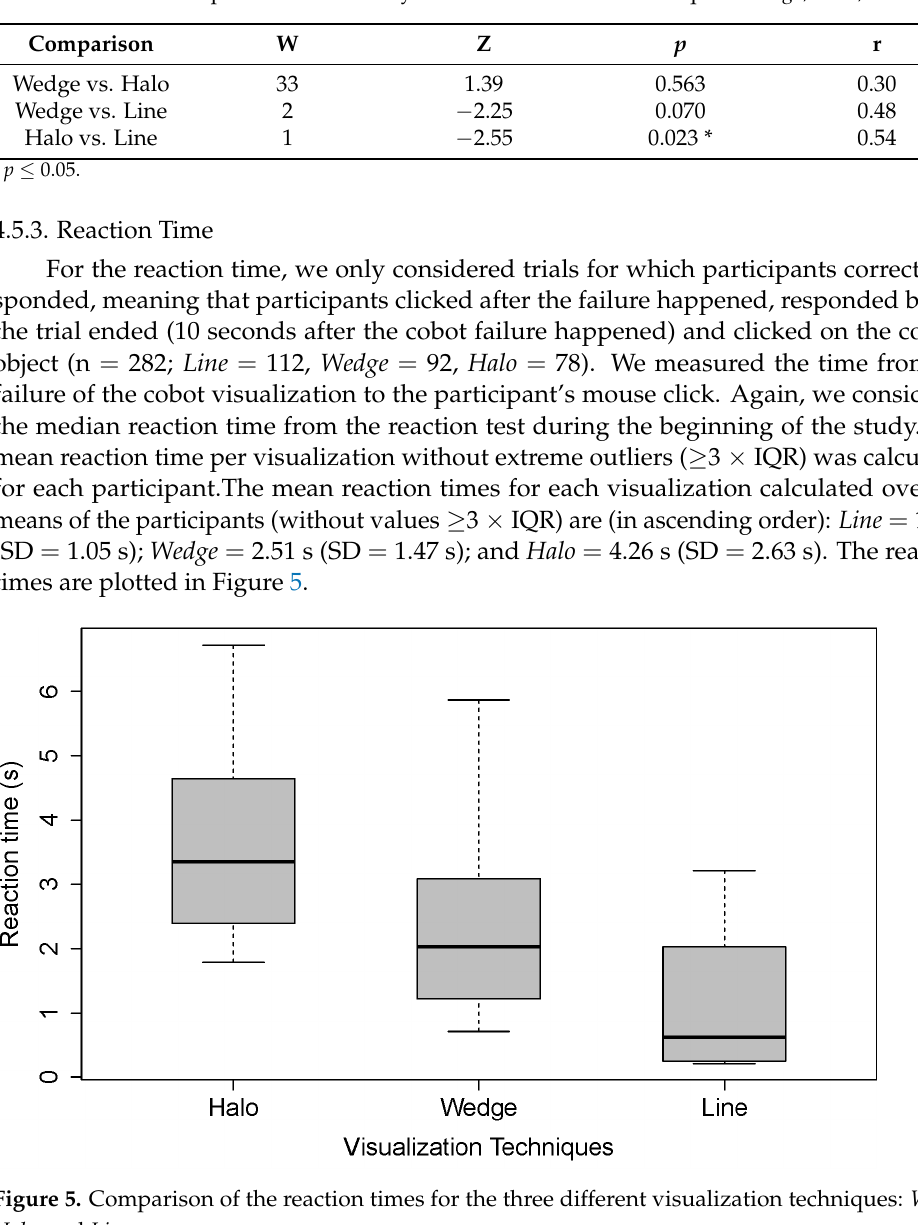
Table 1. Pairwise comparisons of accuracy for the visualization techniques: Wedge , Halo , and Line .